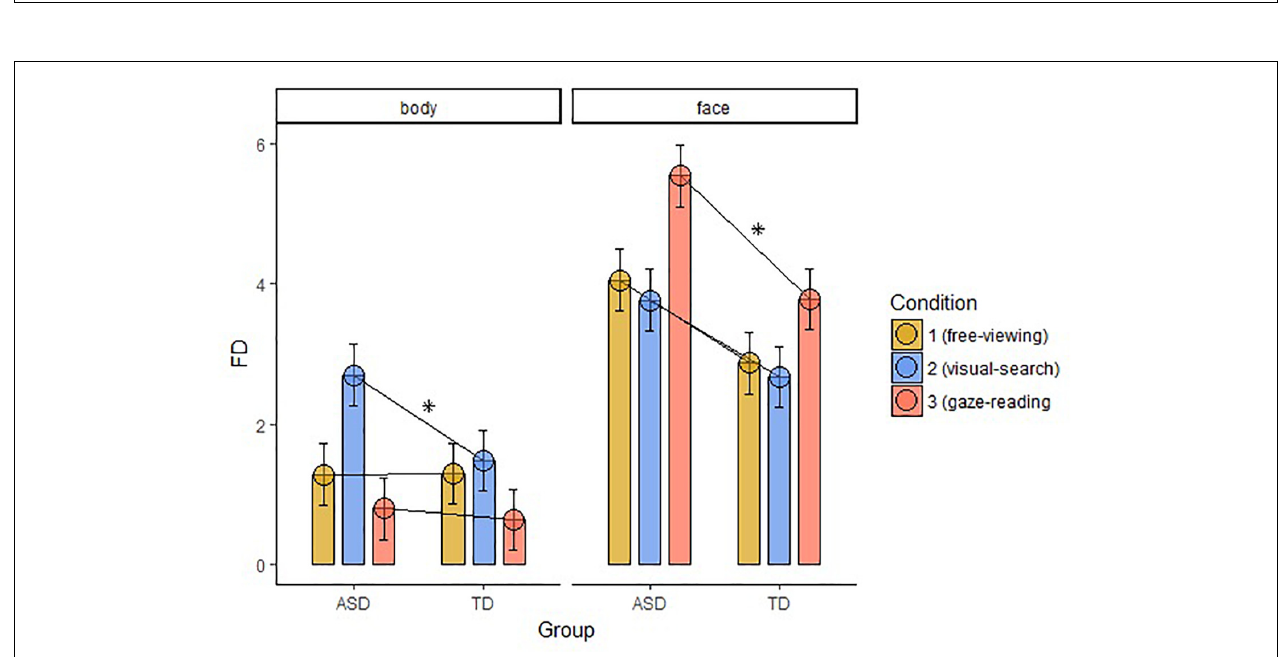
FIGURE 3 | Boxplot of FF% across groups and conditions. The circles drawn on the box represent the mean FF% by group and condition. The dotted line marks the chance level of hitting the AOI face first. The bracket indicates general comparisons between and within groups (FF%, proportion of first fixations to face; ASD, autism spectrum disorder; TD, typical development; ∗ , parameter significantly above chance level; NS, non-significant comparison).